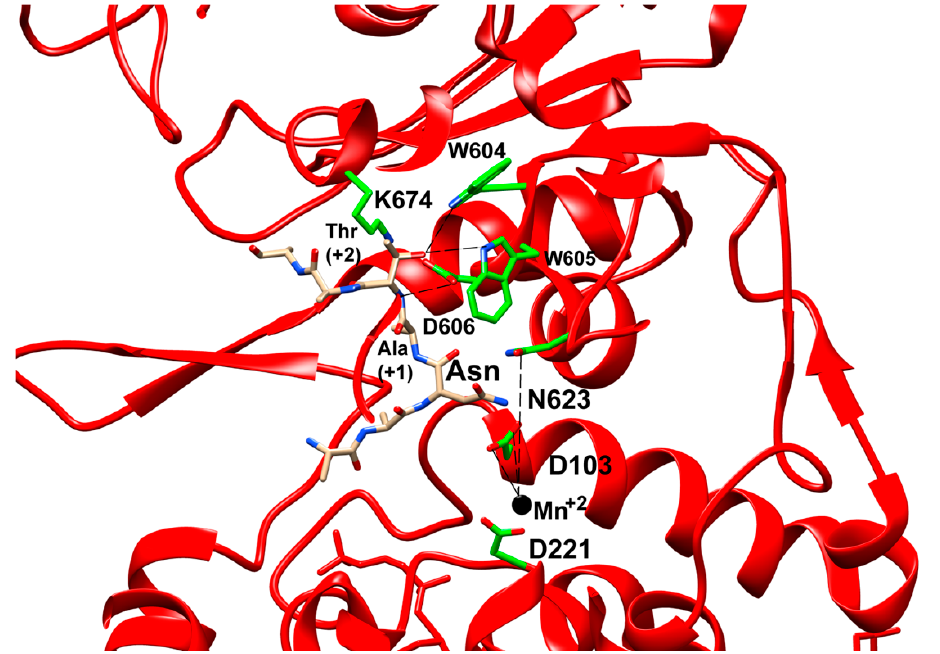
Figure 8. Close-up view of structure of STT3B (PDB ID: 6S7T) in cartoon representation. Residues interacting with Thr at +2 position of the acceptor peptide and with metal ion are shown as sticks and labeled. The H-bond formed by WWD motif to +2 Thr and metal to residue co-ordination are shown with dashed lines. D103 and N623 in STT3B correspond to D56 and E319 in bacterial PglB.